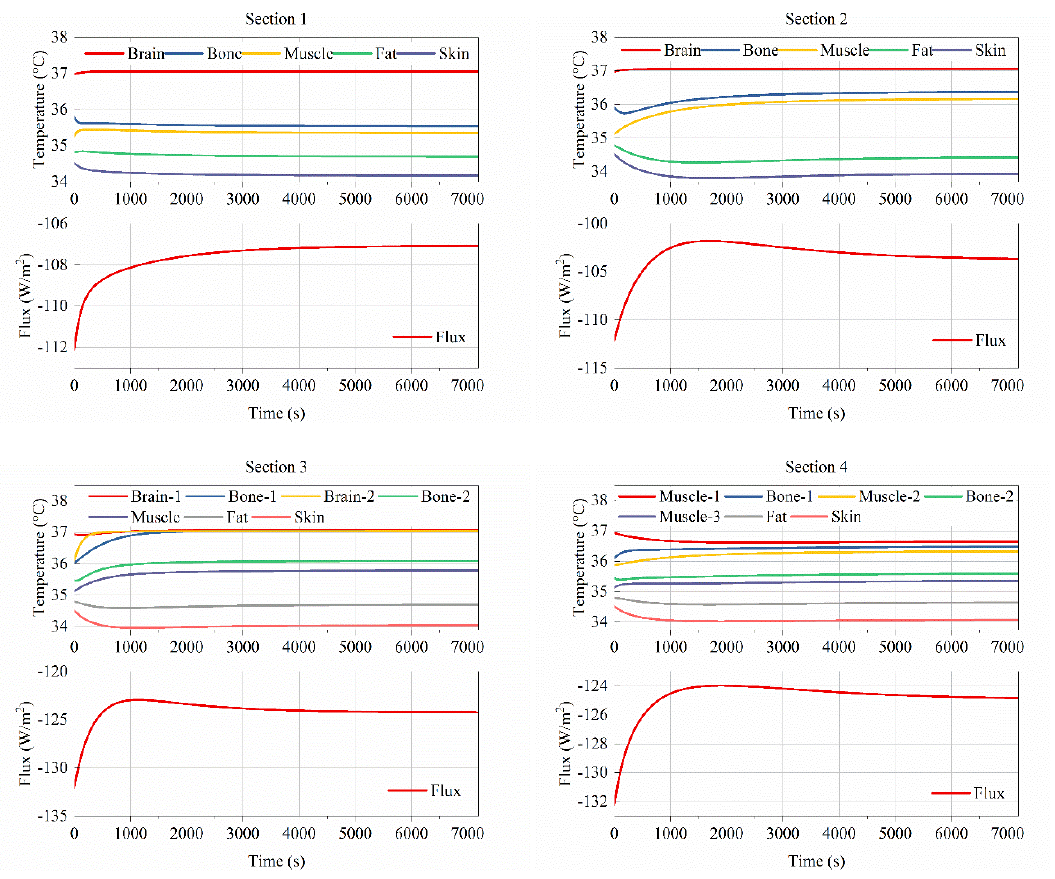
Figure 6. Comparison of the temperatures influenced by different compositions and structures of different layers of the head.